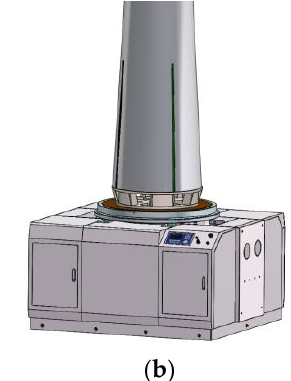
Figure 4. Schematic diagram of the measurement principle of the torsional pendulum period.